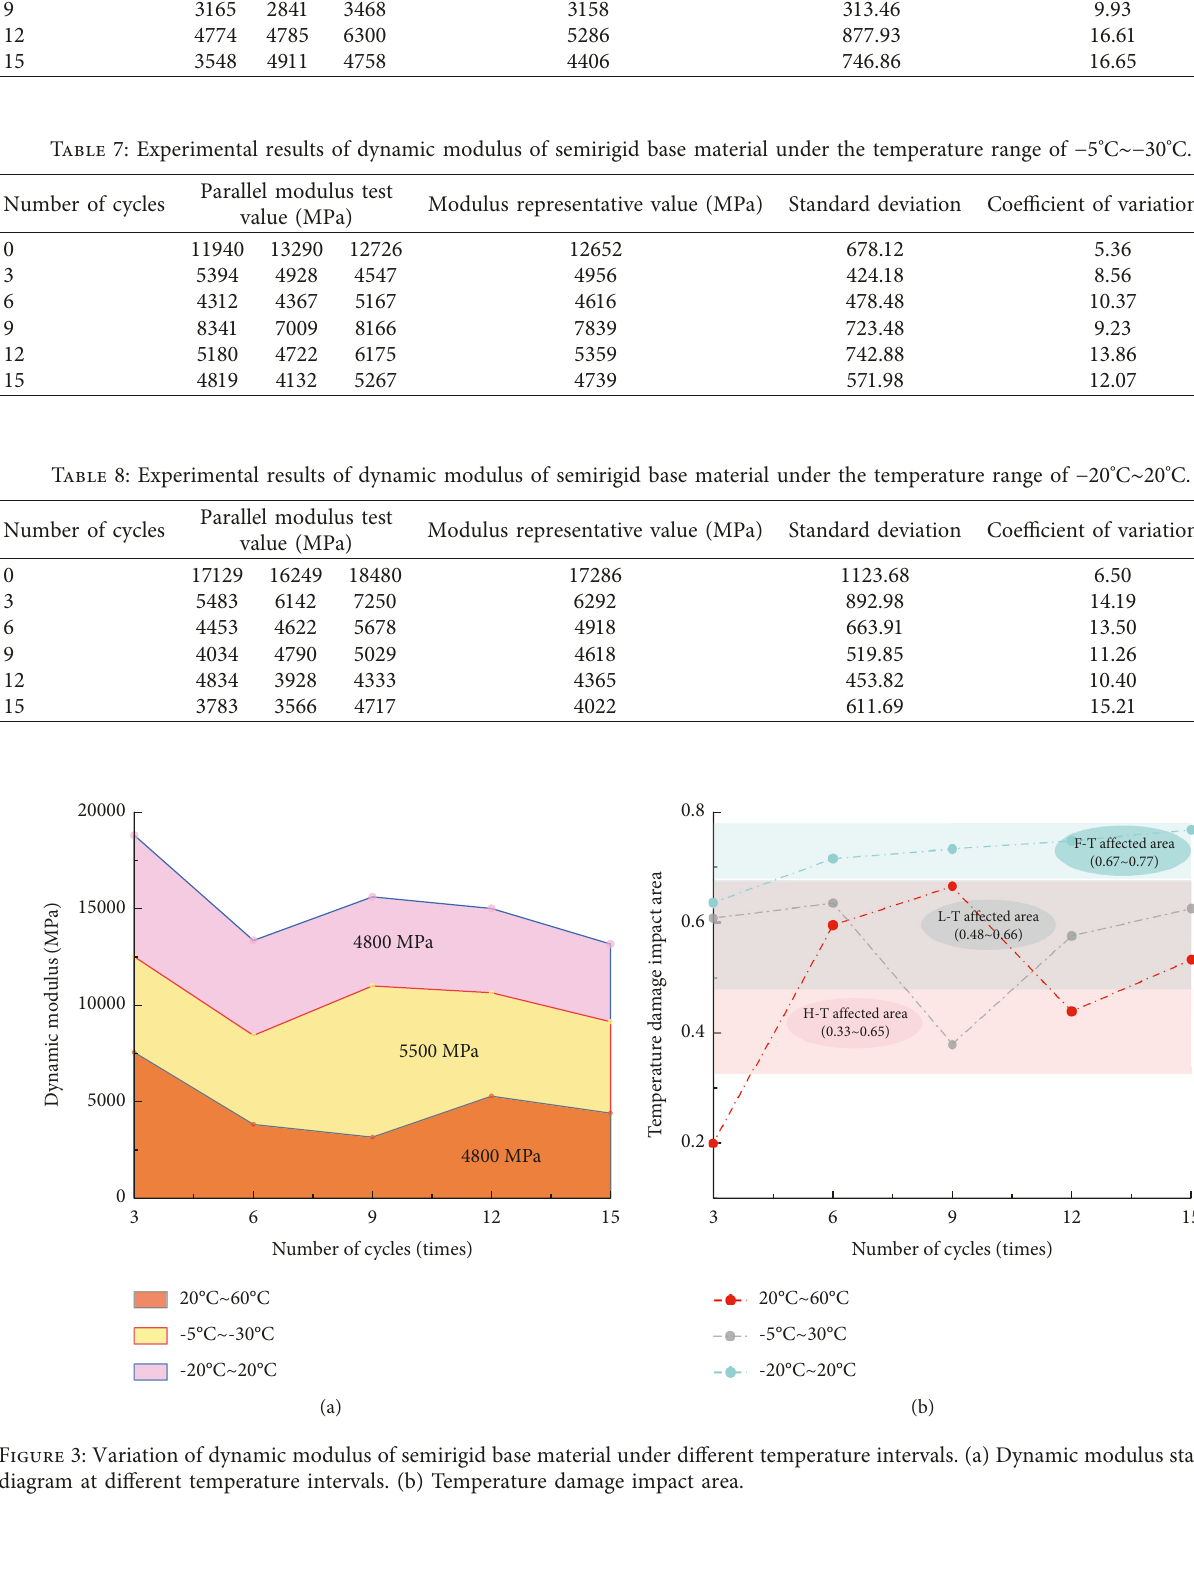
Table 7: Experimental results of dynamic modulus of semirigid base material under the temperature range of